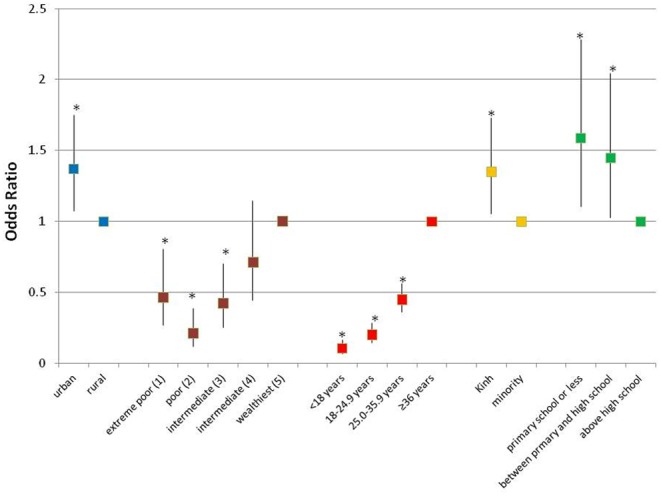
Unadjusted odds ratios for overweight/obesity for Vietnamese women of reproductive age.